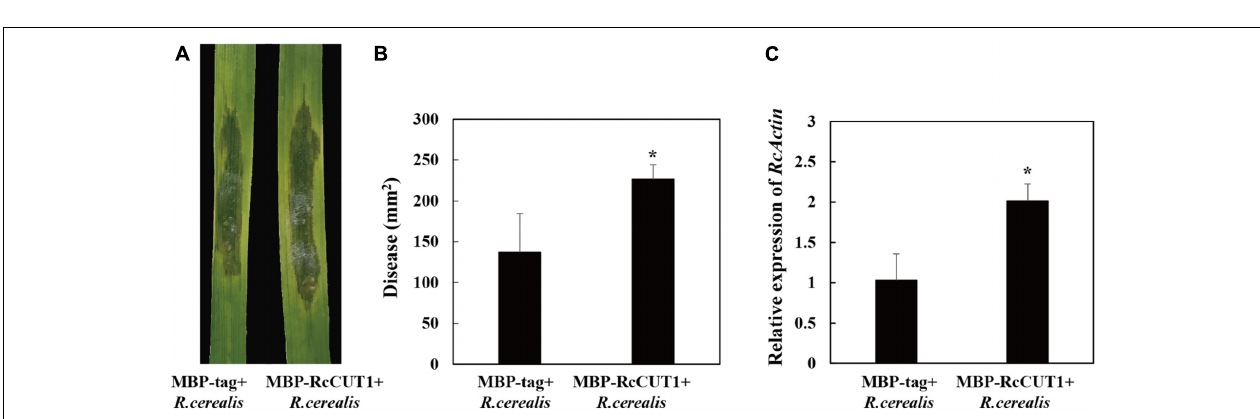
FIGURE 7 | Induction of defense response genes by RcCUT1 from Rhizoctonia cerealis . Expression analysis of defense-related genes in wheat leaves 3 days after inoculation with the MBP-RcCUT1 and the check sample MBP-tag at a concentration of 5 µ M. The wheat Actin gene was used as an internal control to normalize the data. Error bars were calculated based on three replicates. Double asterisk ∗∗ indicates significant difference between MBP-RcCUT1 treatment and MBP-tag treatment ( t -test; P < 0.01).